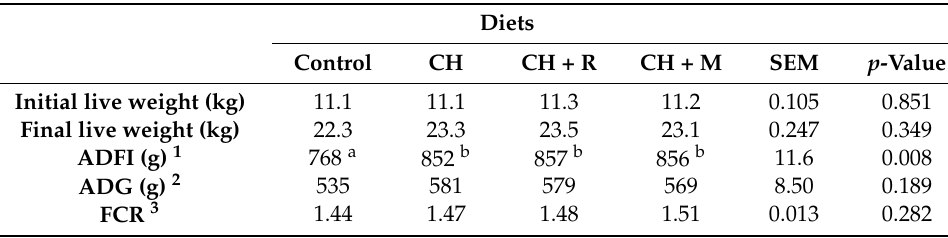
Table 2. Effect of experimental diets on feed intake and growth performance of piglets.